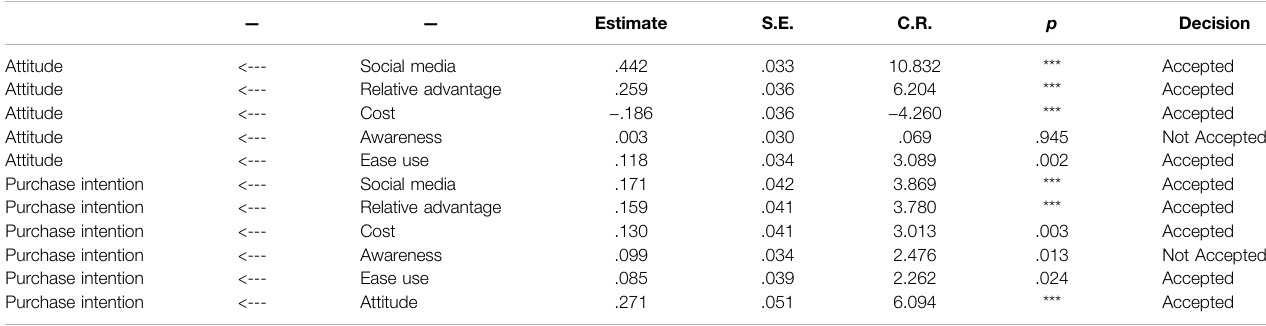
TABLE 4 | Path analysis Regression Weights: (Group number 1 - Default